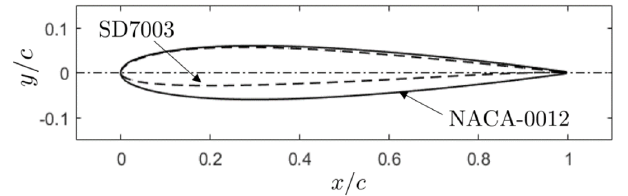
Figure 5. NACA-0012 and SD7003 airfoils employed in experimental study of Yakhina et al. [15]. Concurrently and in close collaboration with experimental efforts of Yakhina et al.